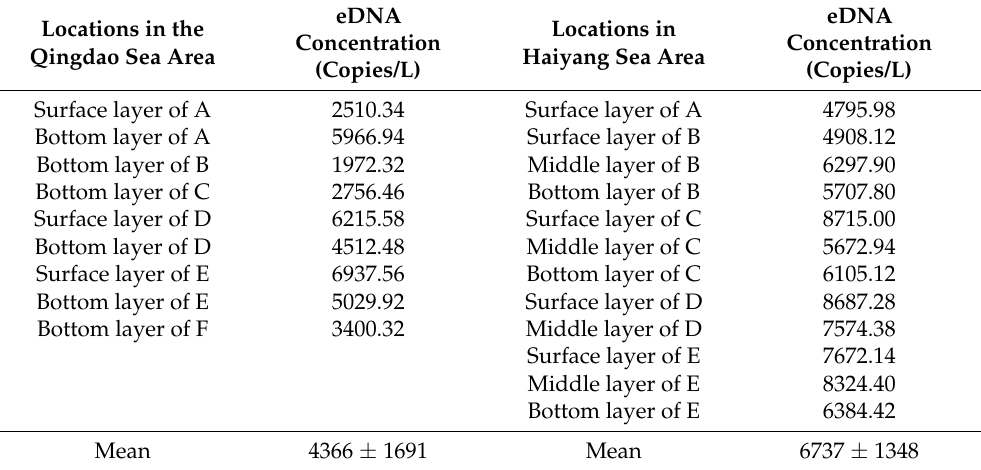
Table 1. The eDNA concentration in the Qingdao sea area and Haiyang sea area.